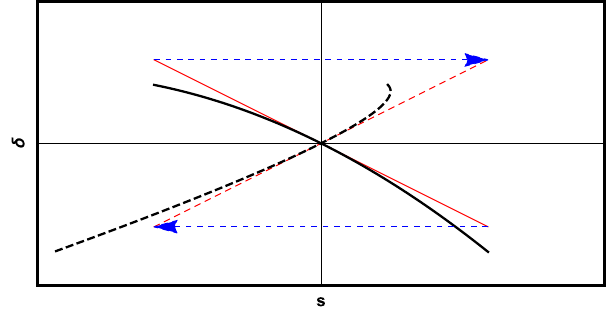
FIG. 16. Change in curvature as an example bunch (black) undergoes a linear compression (solid to dashed). The same compression acting on a linearized bunch is shown in red.